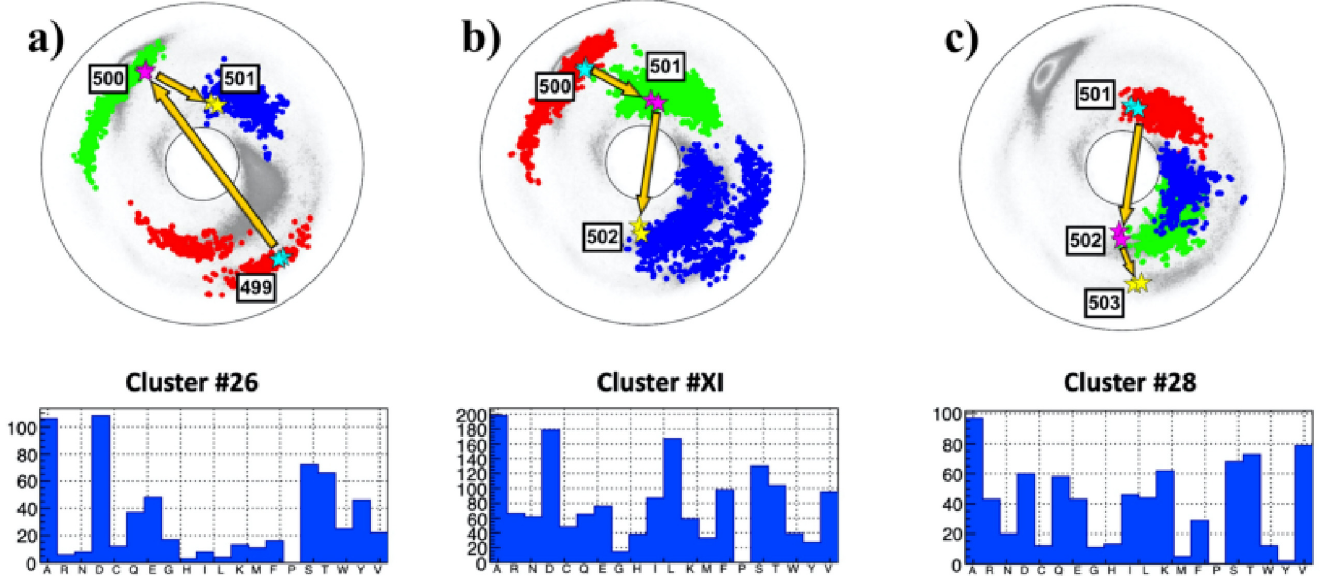
Fig 10. The ( κ i , τ i ) spectrum for i = 499 − 503; this engages sites 497 − 504 along the C α backbone. Data for 501N is only available in the open state chains B and C. Panel a) The spectrum for P:(499, 500, 501), in the background of the best matching cluster #26 in [41]. The most common amino acids in the cluster are A and D. Notably, Y is more common than N. Panel b) The spectrum for A:(500, 501, 502), in the background of the best matching cluster #XI in [41]. The most common amino acid in the cluster are A and D; now N is more common than Y. Panel c) The spectrum for F:(501, 502, 503), in the background of the best matching cluster #28 in [41]. The most common amino acid in the cluster is A, there is also propensity to D but V is more common, N appears but Y is absent.